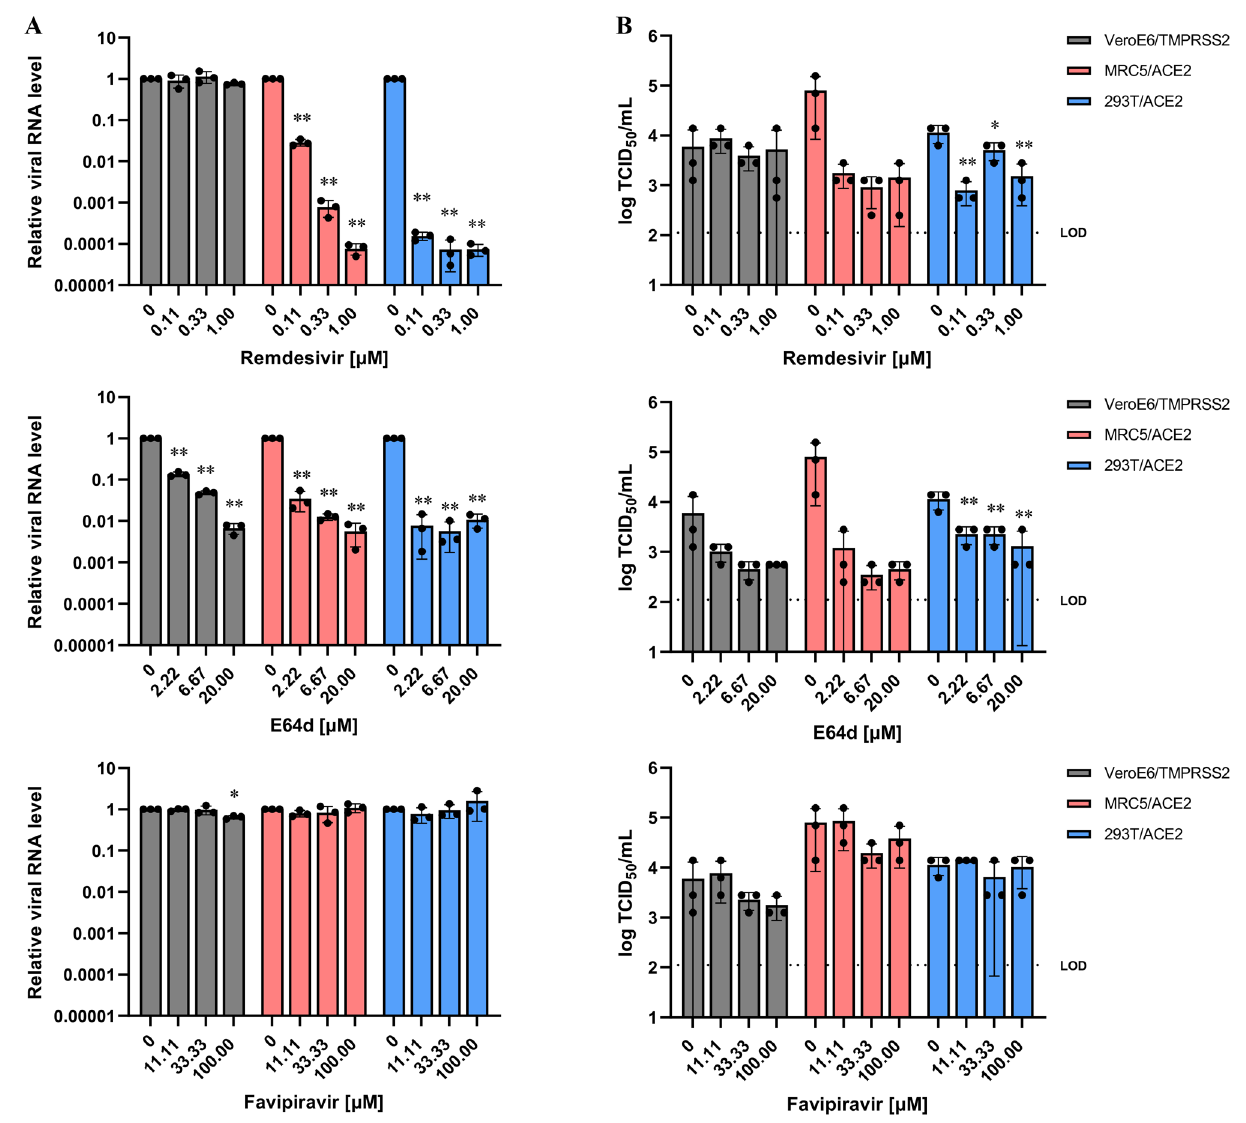
Figure 3. SARS-CoV-2 infection of MRC5/ACE2 cells and sensitivity to antiviral agents. ( A ) VeroE6/ TMPRSS2, MRC5/ACE2 and 293T/ACE2 cells were all treated with remdesivir (0.11, 0.33 and 1 μM, red bars), E64d (2.22, 6.67 and 20 μM, blue bars) or favipiravir (11.11, 33.33 and 100 μM, green bars) for 30 min prior to infection with SARS-CoV-2 at an MOI of 0.1. At 24 hpi, relative expression of the nucleocapsid gene was evaluated by qRT-PCR with β-actin mRNA used as a reference control. Data represent the average of three replicates from a single experiment, and error bars indicate SD. Statistically significant differences were determined with a one-way ANOVA followed by Dunnett’s multiple comparisons test; * P < 0.05 and ** P < 0.0001. ( B ) Supernatants from cultures described in ( A ) were collected at 24 hpi; serial dilutions were prepared and used to inoculate a monolayer of VeroE6/TMPRSS2 cells. The infectious viral titers were measured at 72 hpi via calculation of the TCID 50 /ml. Data represent the average of three replicates from a single experiment, and error bars indicate SD. Dotted line indicates the LOD. Statistically significant differences were determined with a one-way ANOVA followed by Dunnett’s multiple comparisons test; * P < 0.05 and ** P < tively. Immune complexes were detected using horseradish peroxidase (HRP)-conjugated secondary antibodies and SuperSignal West Femto Maximum Sensitivity Substrate (Pierce; Thermo Fisher Scientific). Flow cytometry. Cells were harvested with Cell Dissociation Buffer (Gibco) and incubated with anti- hACE-2 antibody (AF933, R&D Systems, Minneapolis, MN, USA) or goat-derived anti-mouse IgG (A11032, Invitrogen; Thermo Fisher Scientific) isotype control. Cells expressing hACE2 were detected using Alexa Fluor 488-conjugated anti-goat IgG antibody on a FACS Canto flow cytometer (BD Biosciences, San Jose, CA, USA). Data were analyzed with FlowJo version 10.6.0 (BD Biosciences).